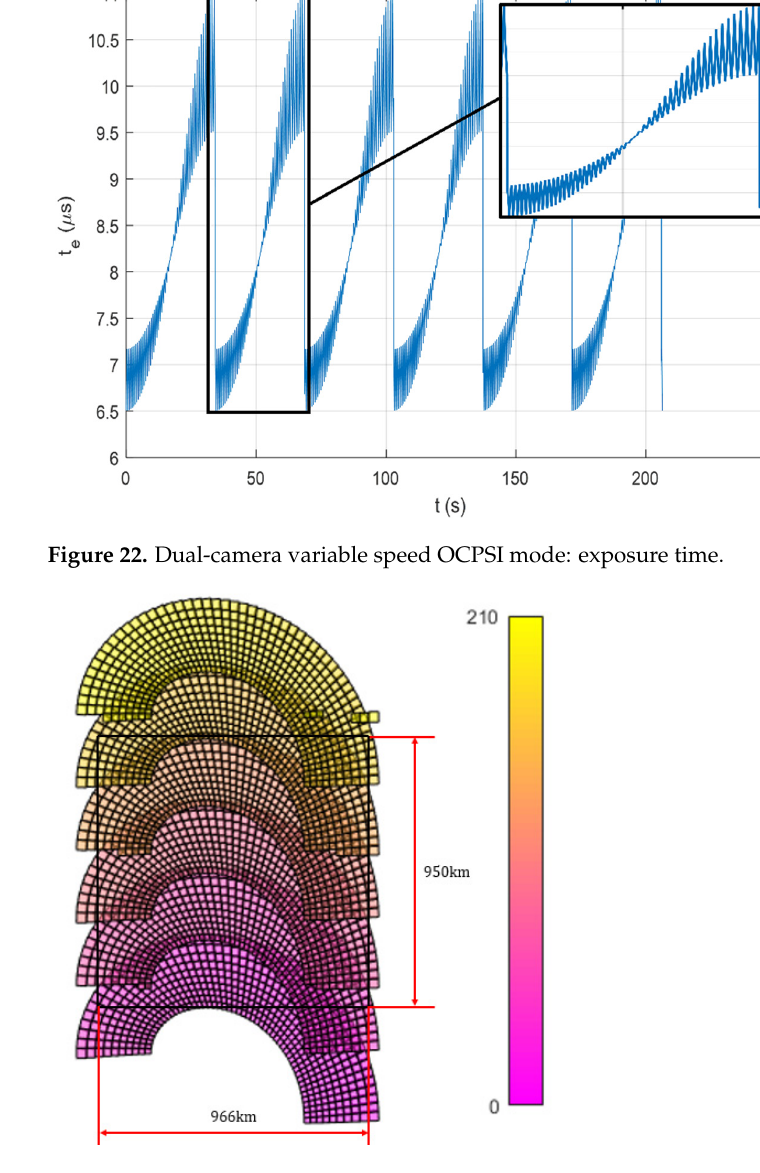
Figure 23. Dual-camera variable speed OCPSI mode ground cover simulation.